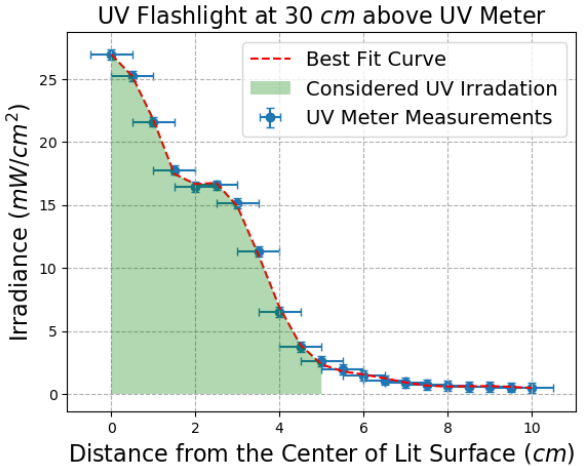
Figure 9. Distance from center vs. Measured Irradiance.